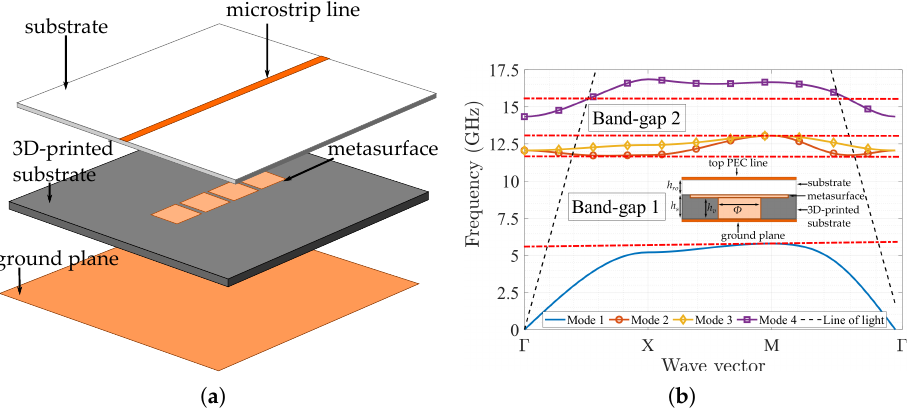
Figure 8. Suspended microstrip with metasurface. ( a ) Exploded view. ( b ) Dispersion diagram with unit cell (cut view).